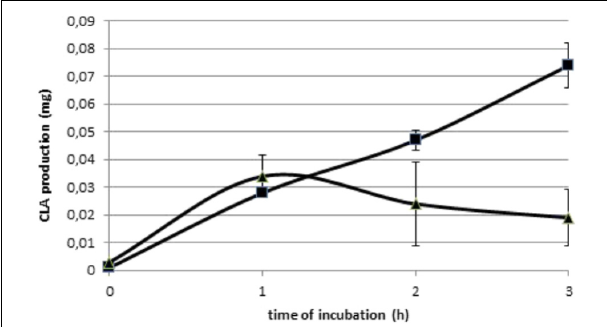
FIGURE 2 | Production (mg) of the two main conjugated linoleic acids: t10,c12-CLA ( (cid:4) ) and c9,t11-CLA ( (cid:78) ), over the 3 h incubations with 1 mg of